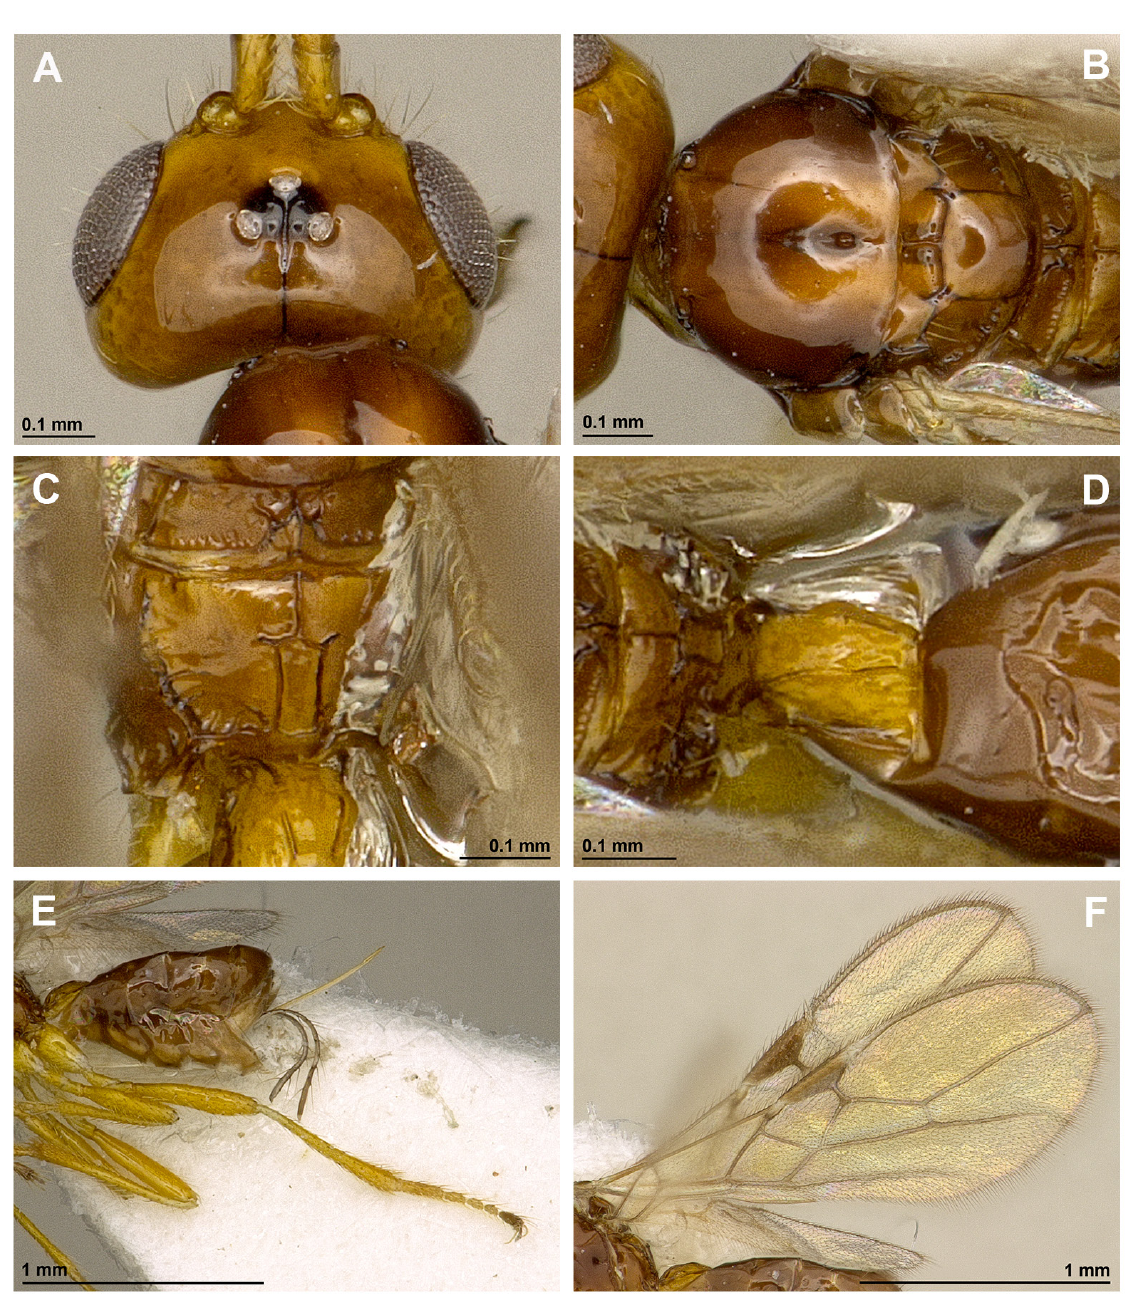
Fig. 71. Asobara vanalpheni van Achterberg, sp. nov., ♀, holotype (RMNH). A . Head, dorsal view. B . Mesoscutum, dorsal view. C . Propodeum. D . First metasomal tergite, dorsal view. E . Hind leg, metasoma and ovipositor, lateral view. F . Fore and hind